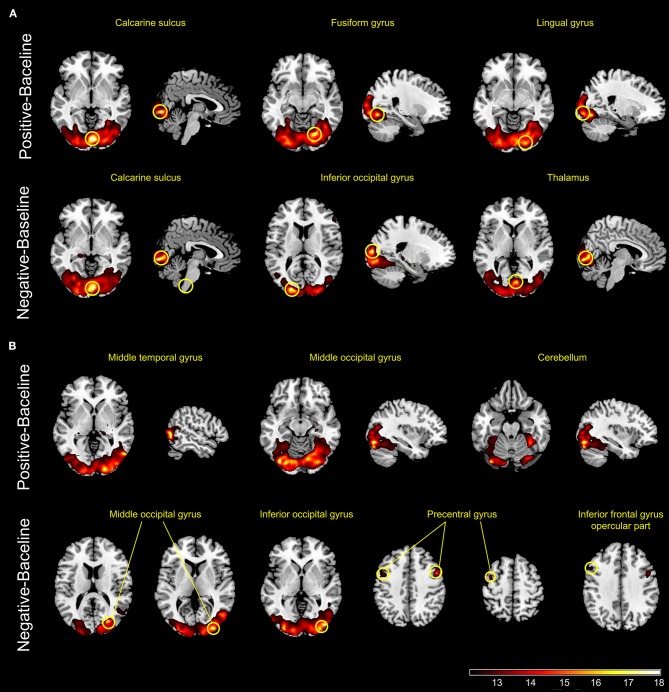
Panels (A,B) show the active regions during tonic pain combined with positive or negative emotional stimuli in healthy controls (A) and patients with bipolar disorder (B) (p < .001, uncorrected).